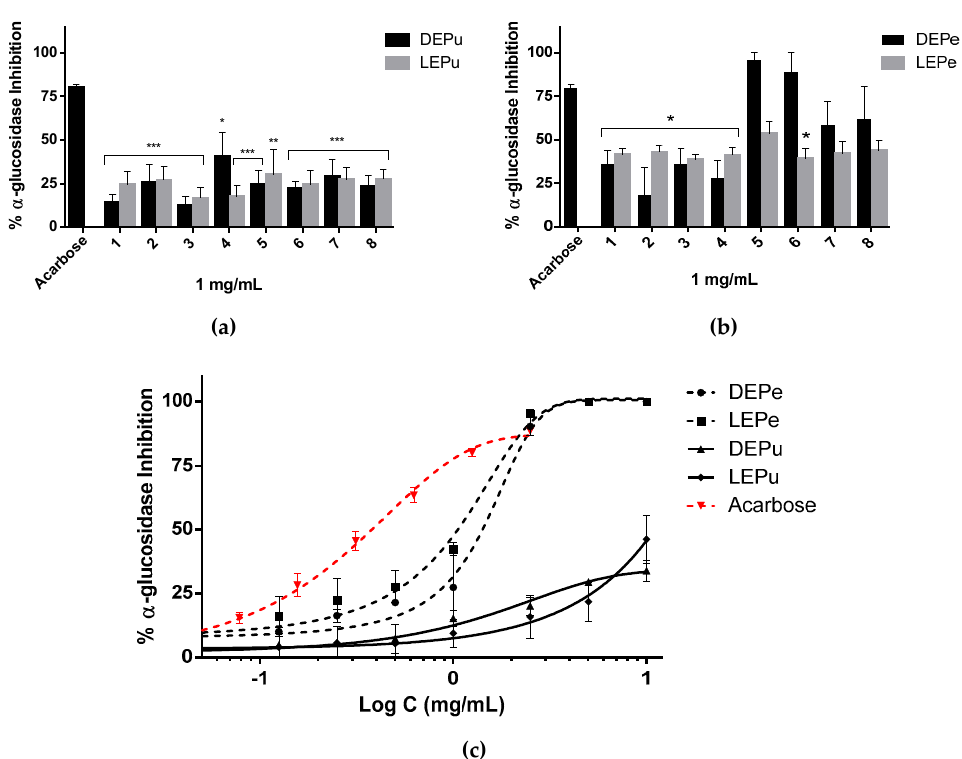
Figure 1. α‐ Glucosidase inhibition: ( a ) inhibition performed by extracts obtained from pulp ( n = 6); ( b ) inhibition performed by extracts obtained from peel ( n = 6); ( c ) inhibition performed by sample 5 for DEPe and DEPu, sample 6 for LEPe and LEPu, and acarbose in a concentration dependent manner ( n = 3). One-way analysis of variance (ANOVA) followed by Dunnet’s test for multiple comparisons: